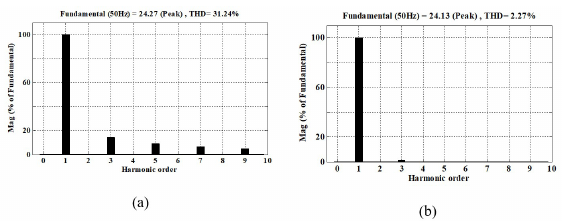
Fig. 5. FFT analysis of grid supply current (a) Before compensation (b) after